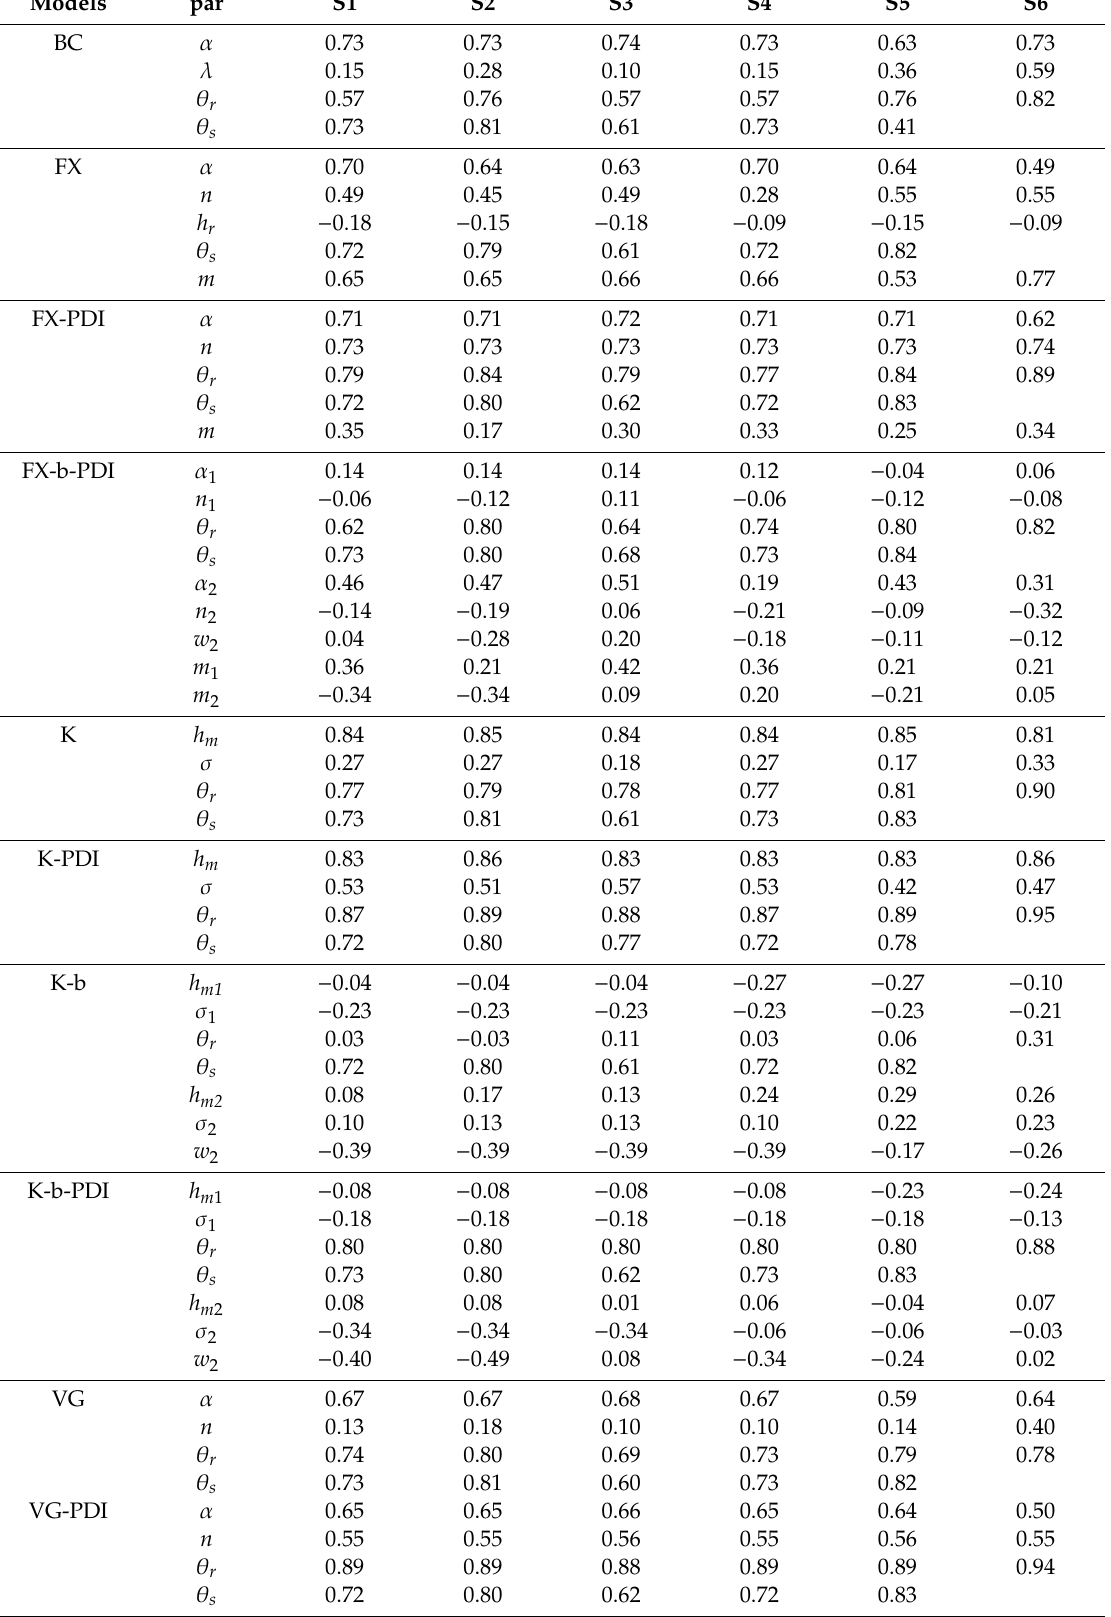
Table 6. The correlation coe ffi cient values between PTF-estimated and fitted model parameters.